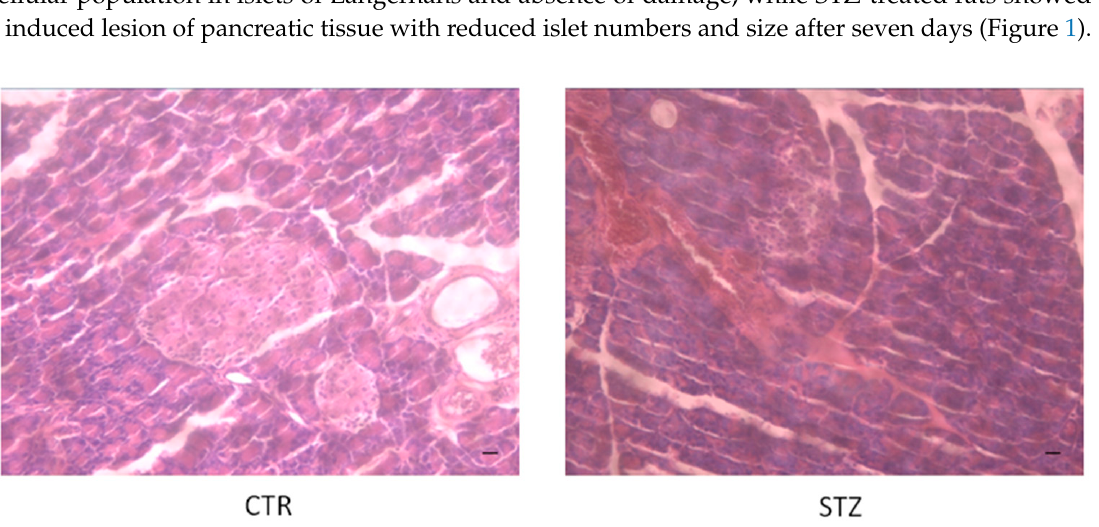
Figure 1. Hematoxylin and eosin (HE) staining. HE of pancreatic tissue from untreated and STZ rats at seven days. CTR = saline-treated rats; STZ = STZ (65 mg/kg/10 mL)-treated rats. Scale bar = 50 µm. Ozone Reduces 4-HNE Adduct in STZ